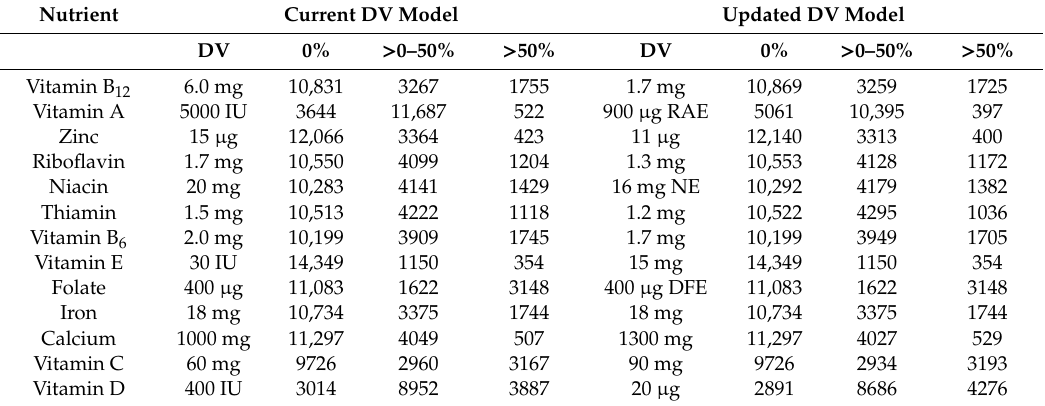
Table 4. Number of US adults aged ≥ 19 years currently obtaining or predicted to obtain 0%, > 0–50%, or > 50% of the Daily Value (DV) from voluntarily fortified foods in Current and Updated DV models,